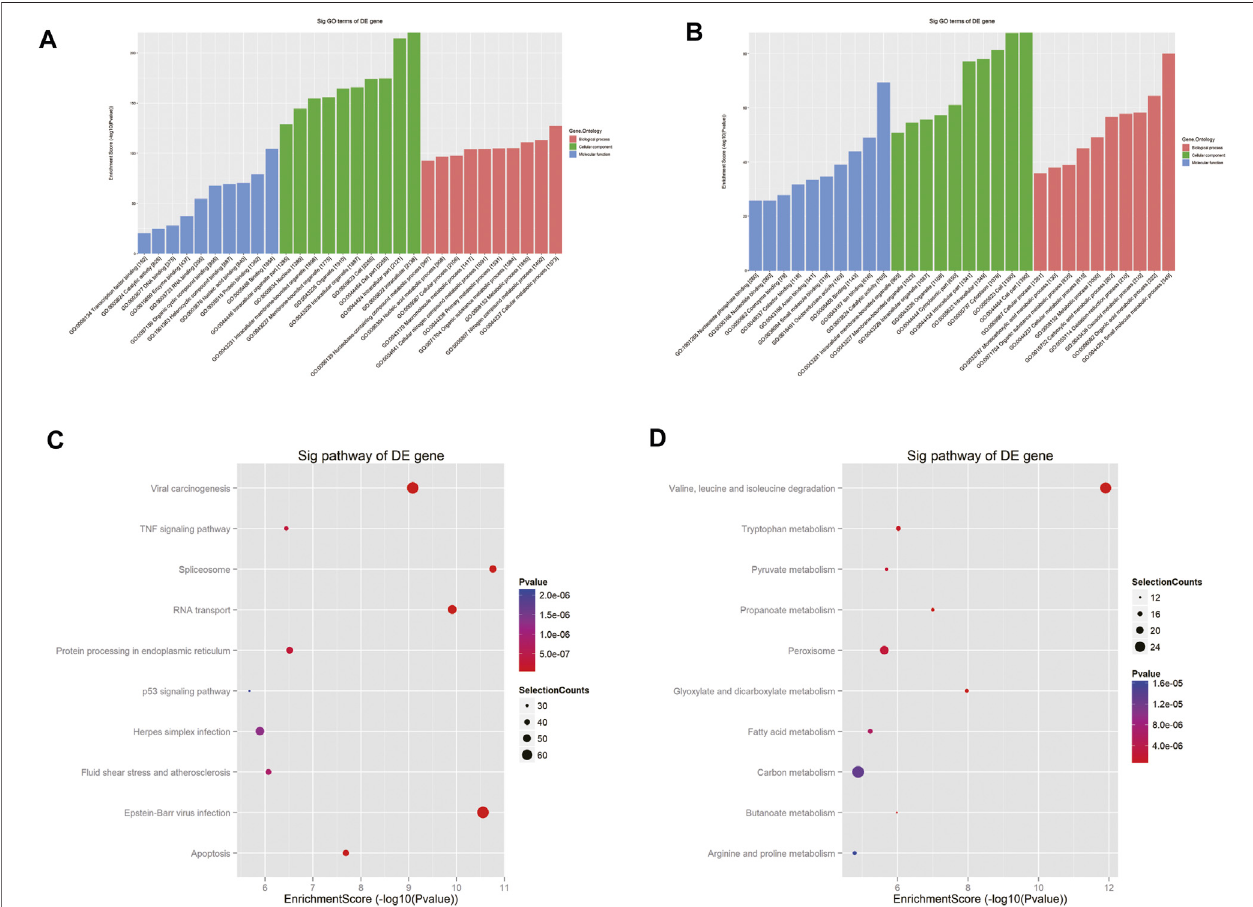
FIGURE 4 | GO and pathway analyses of the host genes of differentially m 6 A modi fi ed RNAs. GO analysis on parental genes of the m 6 A hypermethylated (A) and hypomethylated (B) mRNA transcripts is shown. The vertical axis demonstrates the annotated functions of the target genes. The horizontal axis demonstrates the enrichment score ( − log10 transformed p value) of each cluster. KEGG analysis on parental genes of the m 6 A hypermethylated (C) and hypomethylated (D) mRNA transcripts is shown. The horizontal axis shows the enrichment score ( − log10 transformed p value). Node size: gene count; node color: p value.